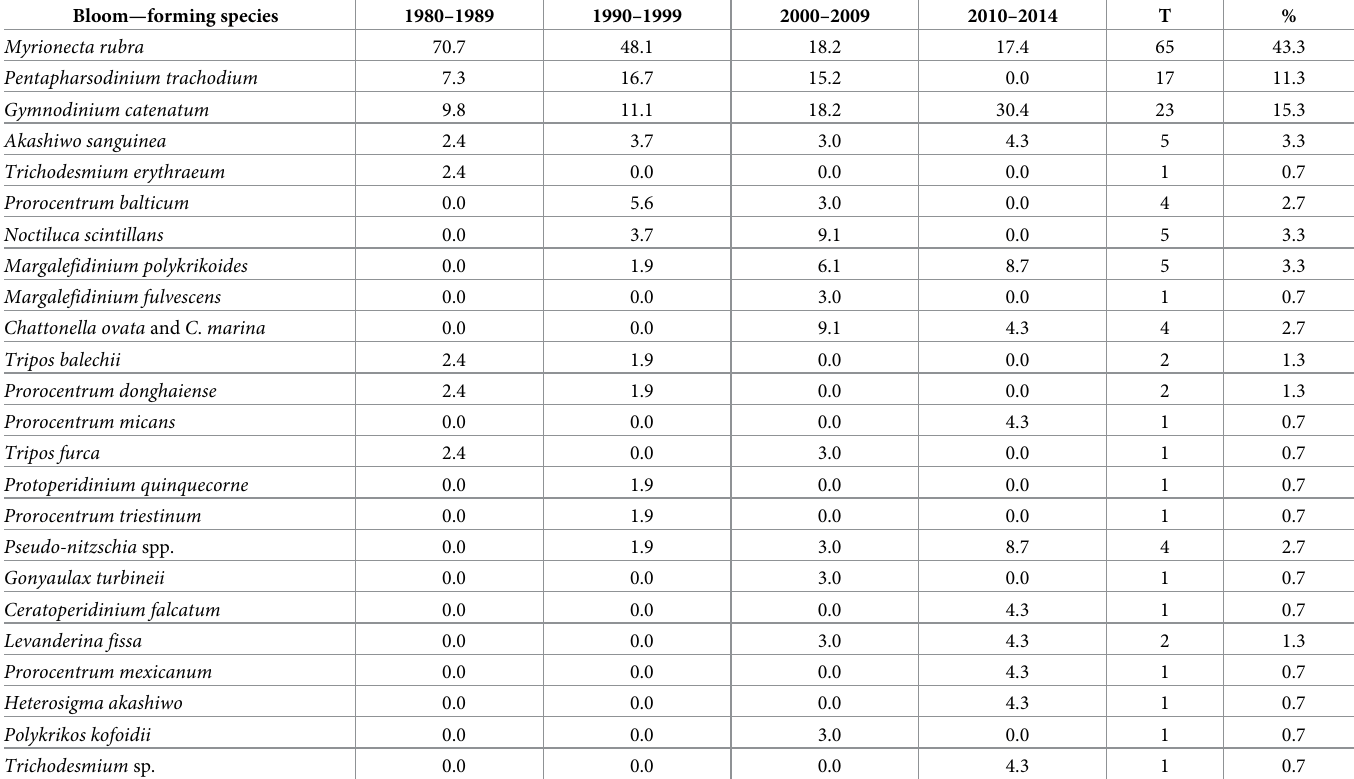
Table 3. Frequency of discoloration-forming species in Mazatlan Bay per decade. T is frequency. Bloom—forming